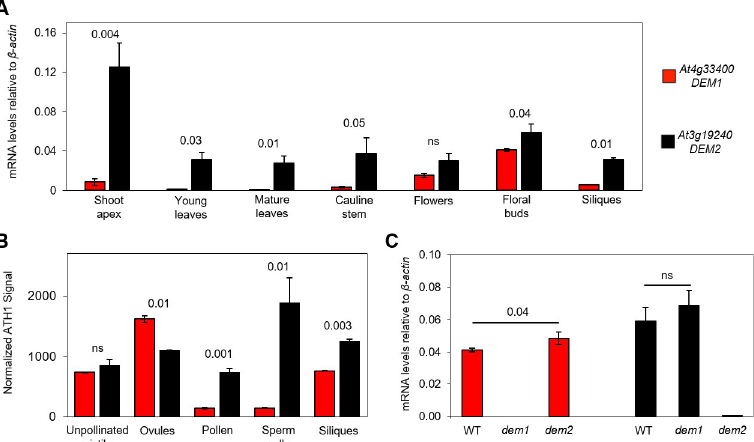
Fig 2. DEM1 and DEM2 mRNA levels in various tissues and sperm cells during vegetative and reproductive development. (A) Quantitative real-time reverse transcriptase PCR (qRT-PCR) was used to examine DEM1 and DEM2 mRNA levels in total RNA extracted from a range of Arabidopsis tissues. Ratios of mRNA levels to that of β - actin mRNA are shown (average ± S.E. for three biological replicates). (B) Microarray-based expression analysis of DEM1 and DEM2 in Arabidopsis reproductive tissues and FACS-purified sperm cells. The figure is based on raw data published by Pina et al . [18], Borges et al . [19] and Boavida et al . [20], and shows mean signal intensities ± S.E. from ATH1 Genechips normalized by the invariant set method, as previously described [19]. Data were derived from two biological replicates for siliques [18], microdissected ovules and unpollinated pistils (UPs) [20], and three biological replicates for pollen and FACS-purified sperm cells [19]. (C) qRT-PCR analysis of DEM1 and DEM2 mRNA levels in total RNA extracted from Arabidopsis wild-type (WT), dem1-2 ( dem1 ) and dem2-2 ( dem2 ) floral buds. Ratios of mRNA levels to that of β -actin mRNA are shown (average ± S.E. for three to six biological replicates). P -values were calculated using one-way ANOVA to indicate significant differences between DEM1 and DEM2 expression in the different tissues and sperm cells of wild-type plants ( A, B ), or between floral buds of wild-type and dem plants ( C ).